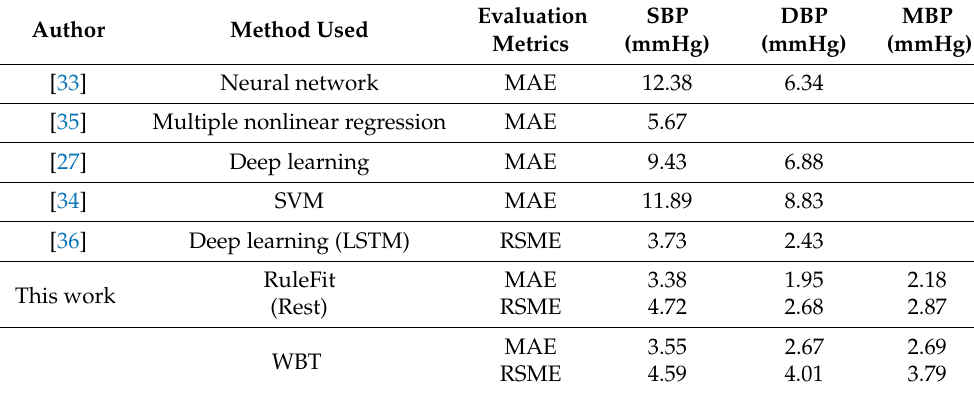
Table 3. Comparison of the results of this work with related works. SVM, support vector machine; SBP, systolic blood pressure; DBP, diastolic blood pressure; MBP, mean blood pressure; MAE, mean absolute error; RSME, root mean square error; WBT, weight-bearing